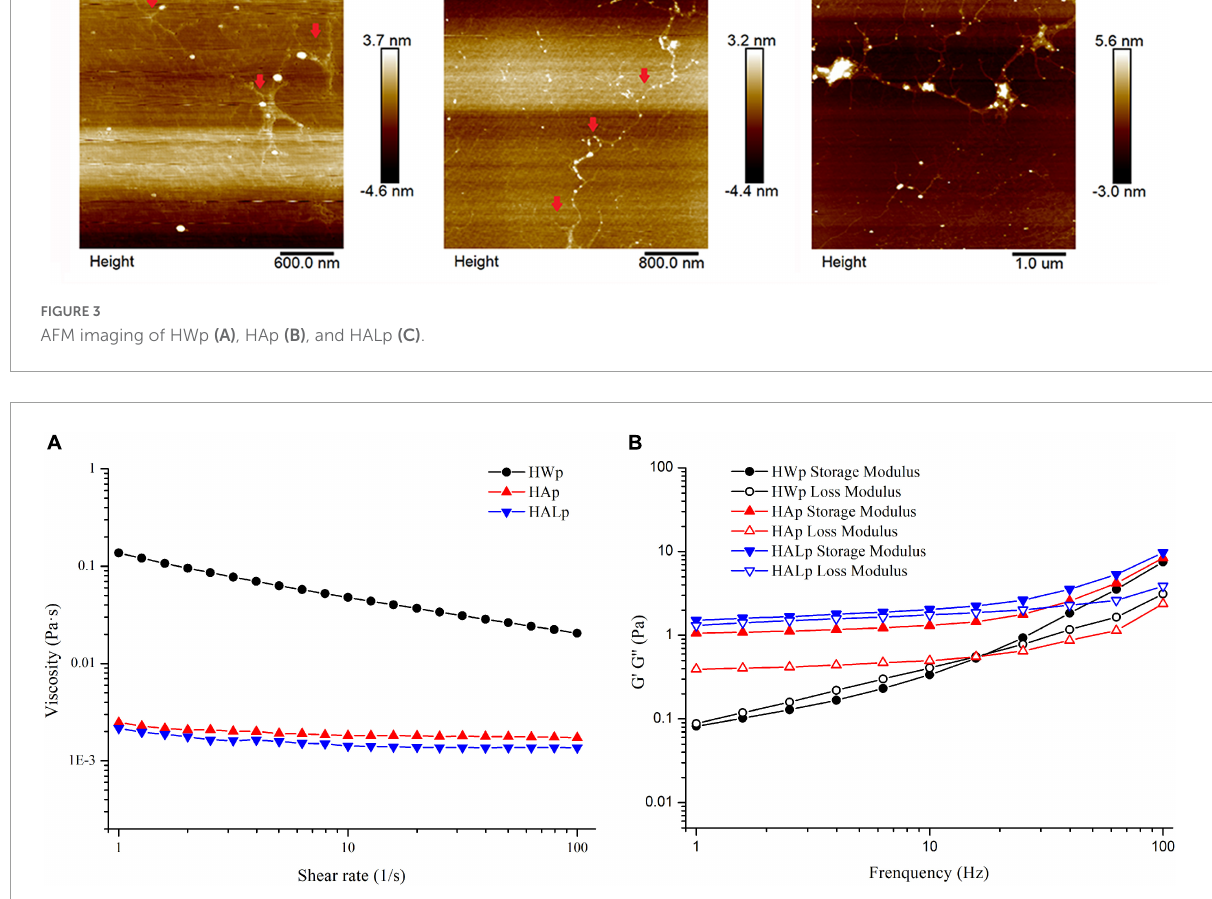
FIGURE4 Rheological characterization of HWp, HAp, and HALp: (A) flow behavior and (B) frequency sweep of modulus G (cid:48) and G (cid:48)(cid:48)